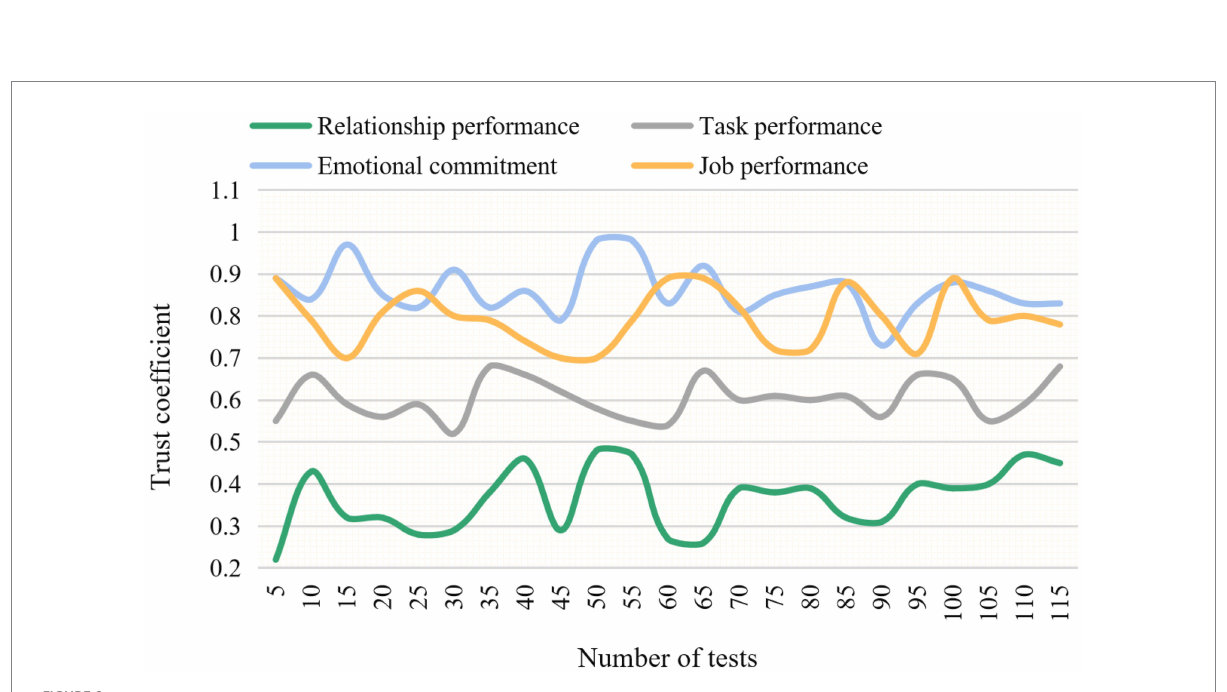
FIGURE 6 Variation of reliability coefficient under different